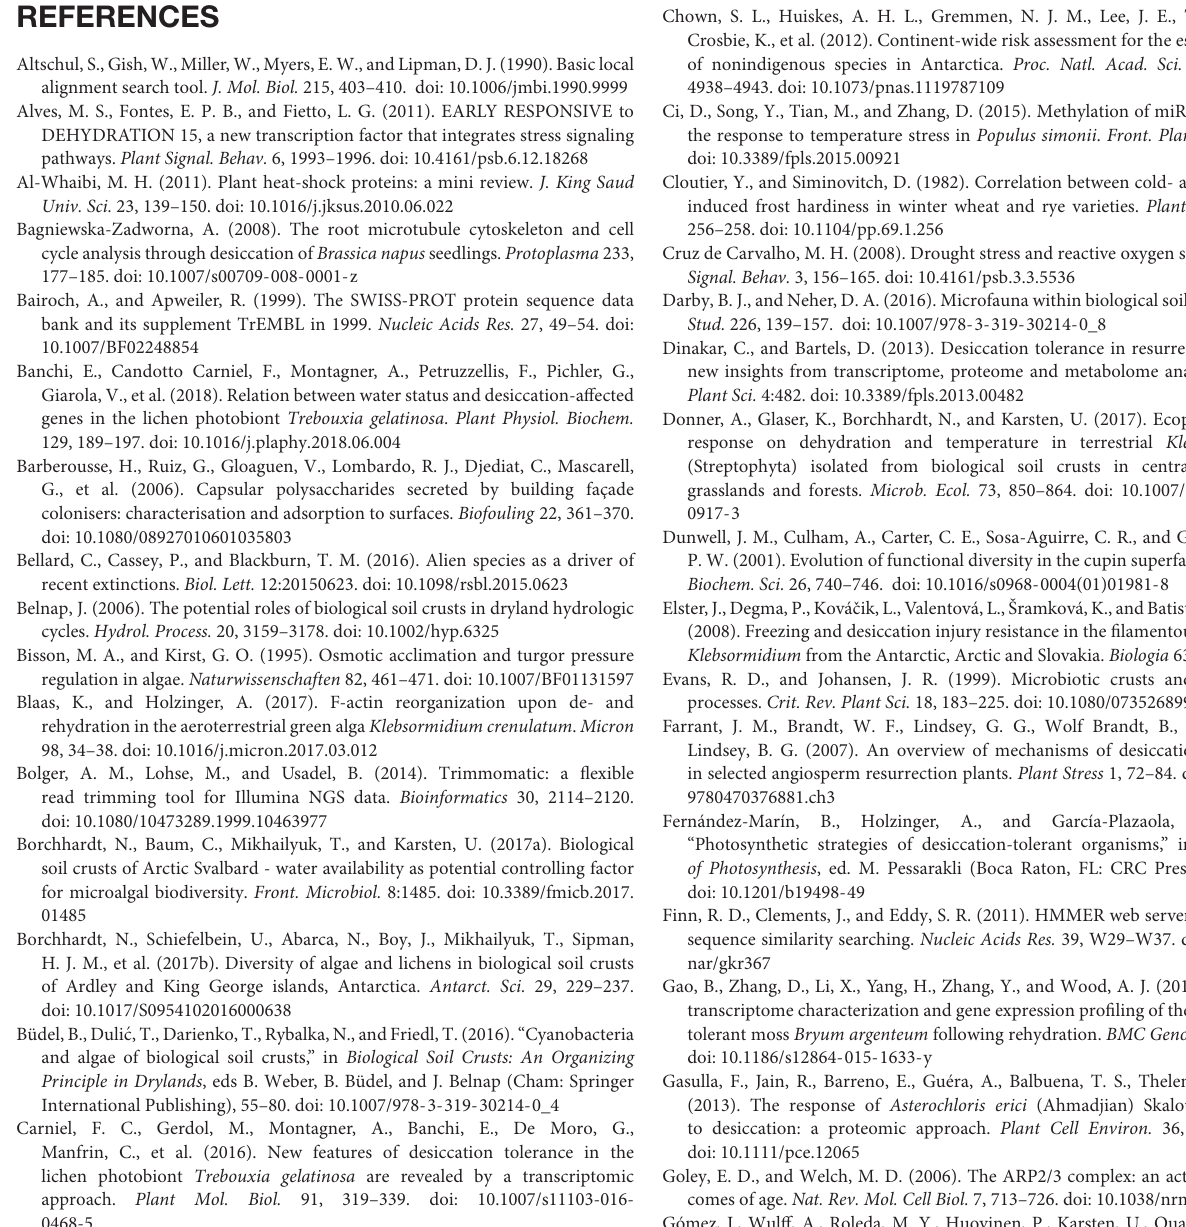
TABLE S2 | GO enrichment analysis. All GO terms enriched are shown for all comparisons. TABLE S3 | Selected genes regulated in K. dissectum and K. flaccidum upon desiccation and/or